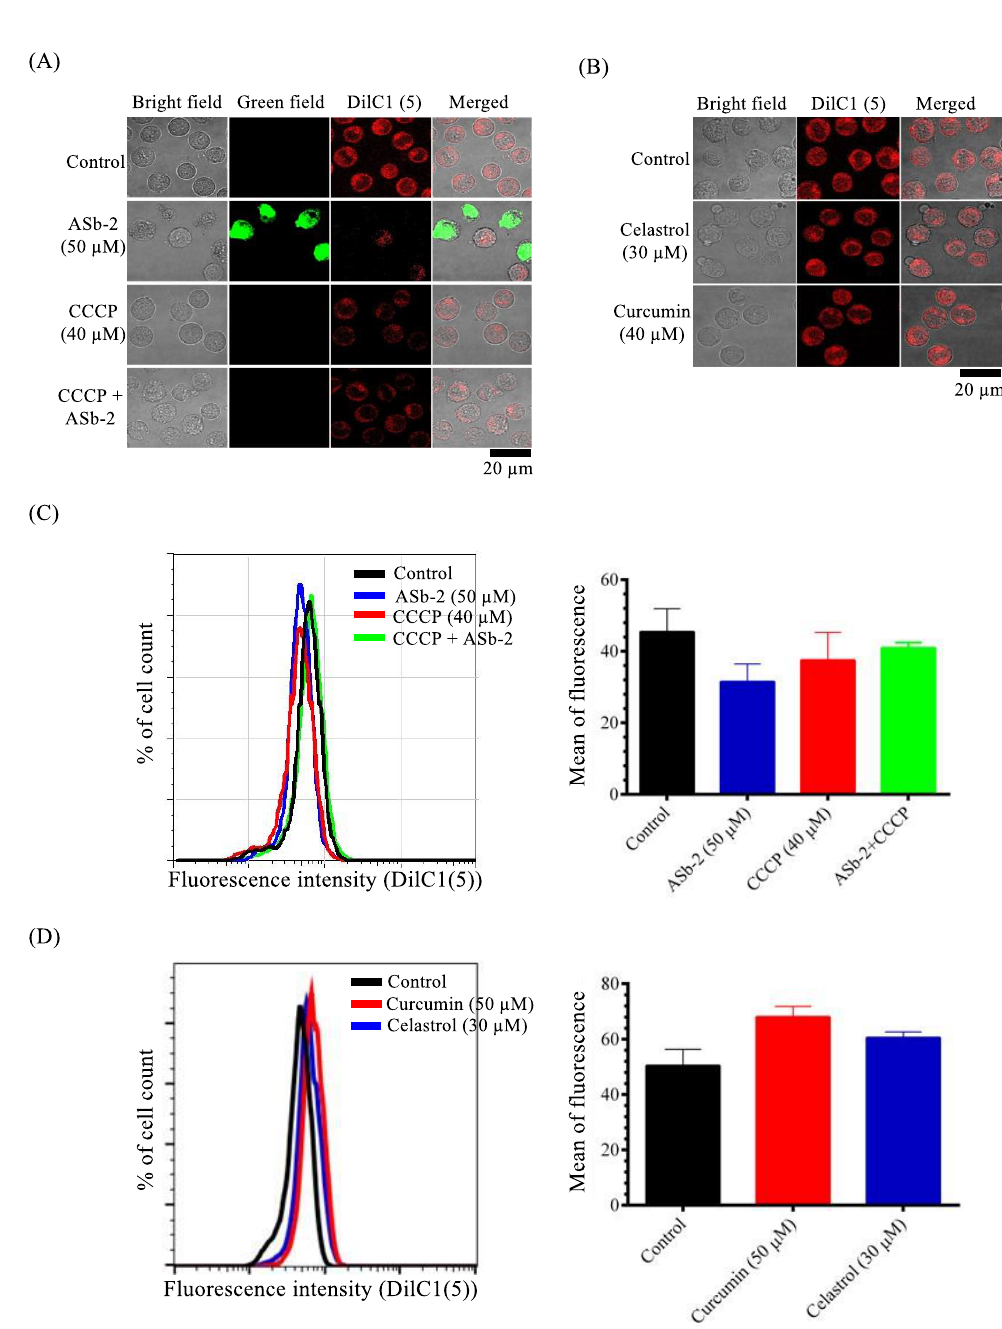
Figure 10. Measurement of Δ Ψ m in Jurkat cells after treatment with ASb-2 (50 µM), celastrol (30 µM), and curcumin (50 µM) in Jurkat cells stained with DilC1(5) (500 nM), as a cationic cyanine dye. ( A , B ) Luminescence confocal microscopic studies of Δ Ψ m in Jurkat cells in the presence of ASb-2 (50 µM), celastrol (30 µM), and curcumin (50 µM) for 1 h at 37 °C with co-staining of DilC1(5) (500 nM). ( C , D ) Flow cytometry analysis of Δ Ψ m in Jurkat cells in the presence of ASb-2 (50 µM), curcumin (50 µM), and celastrol (30 µM) for 1 h at 37 °C with co-staining with DilC1(5) (500 nM).